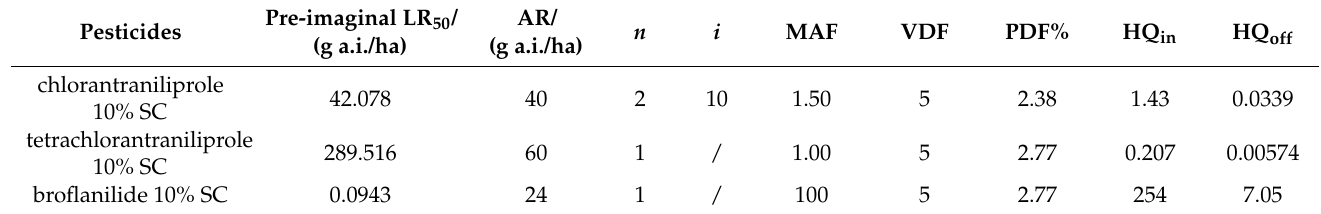
Table 3. Calculation of HQs of three diamide insecticides of C. septempunctata .